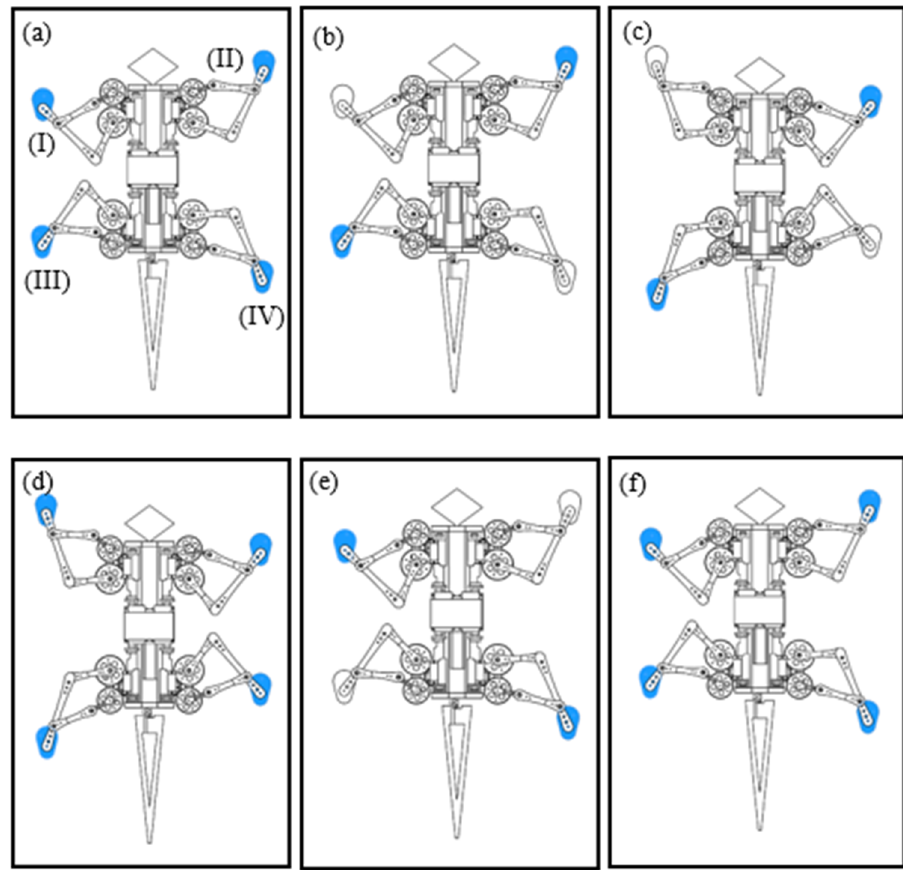
Figure 10. ( a ) The first step in a single cycle, ( b ) the second step in a single cycle, ( c ) the third step in a single cycle, ( d ) the fourth step in a single cycle, ( e ) the fifth step in a single cycle, and ( f ) the sixth step in a single cycle.